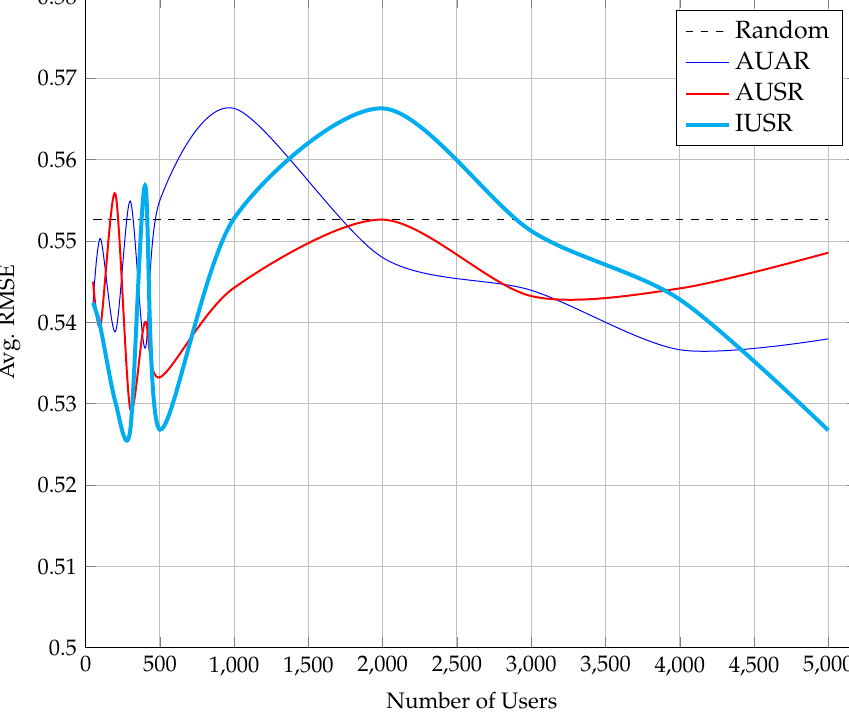
Figure 6. The average Root Mean Square Error (RMSE) for the three scenarios compared to the baseline approach, for different number of replicated